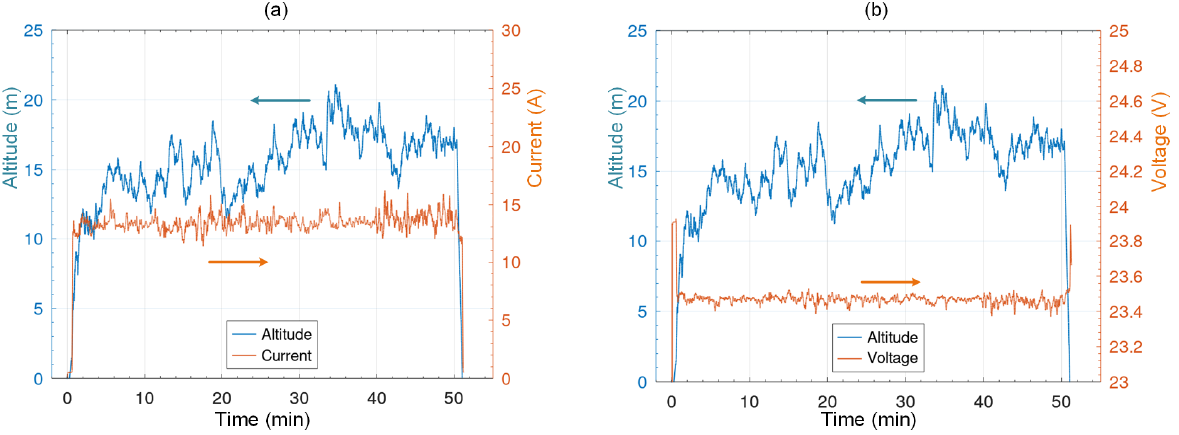
Figure 6. Functional test: ( a ) altitude/current and ( b ) altitude/voltage during 50-min flight.